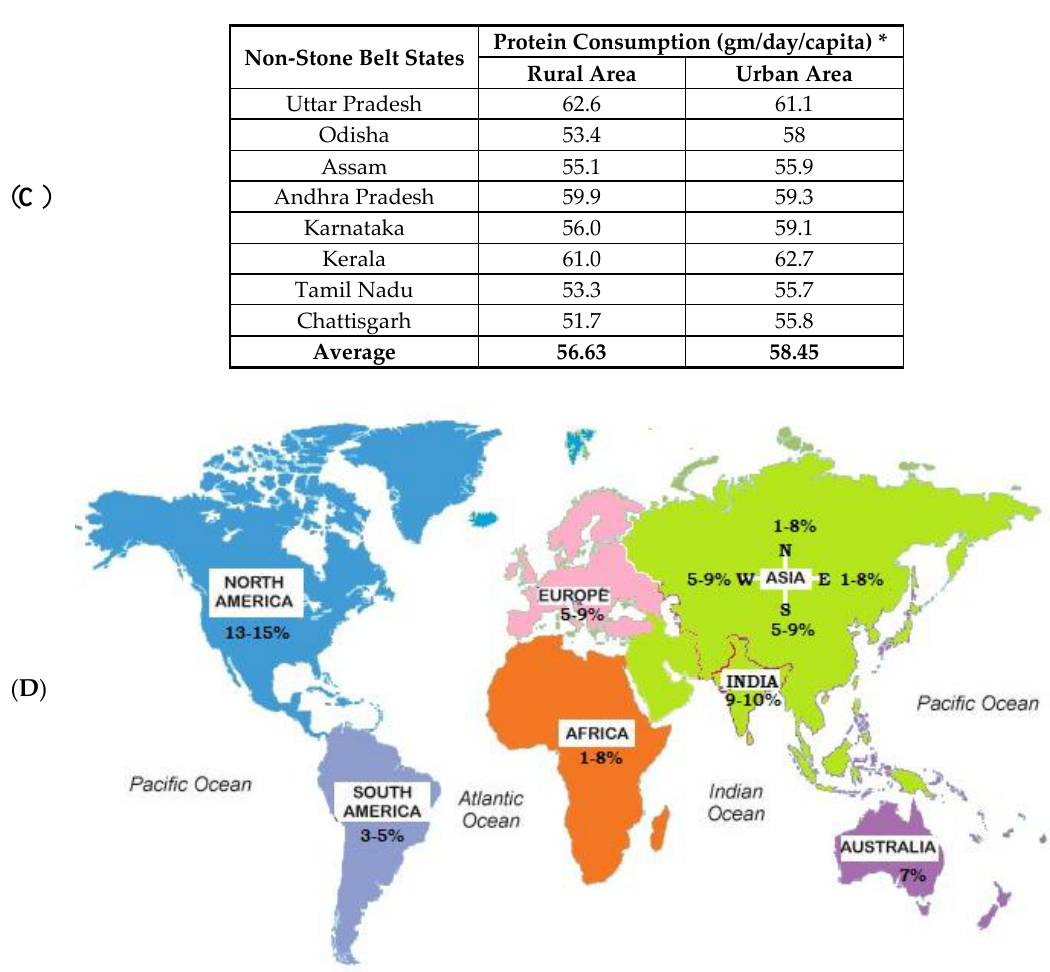
Figure 1. Stone belt Area: ( A ) Major kidney stone prevalent states in the Indian continent. ( B ) Animal protein consumption per gram per day per capita in stone belt Indian states, which leads to KSD (*Ministry of Statistics and Programme Implementation 2012). ( C ) Non-stone belt Indian states are also depicted with the rural and urban population and the animal protein consumption per gram per day per capita. ( D ) Prevalence rates of kidney stones in a global platform, for comparison.